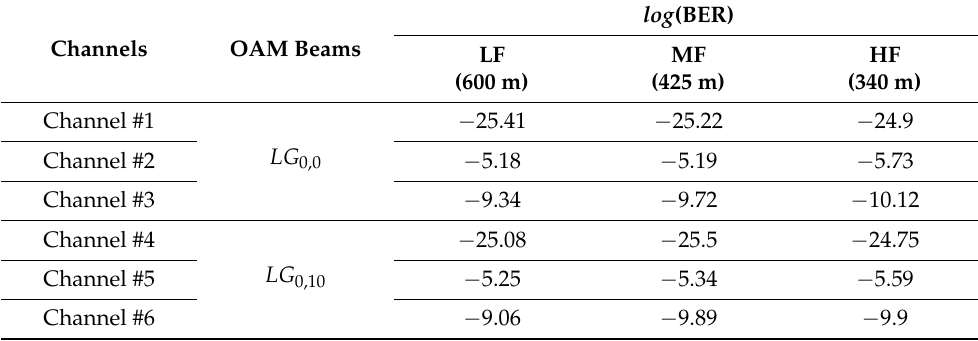
Table 6. Log (BER) values under different fog conditions for OAM/OCDMA-FSO system for six channels.